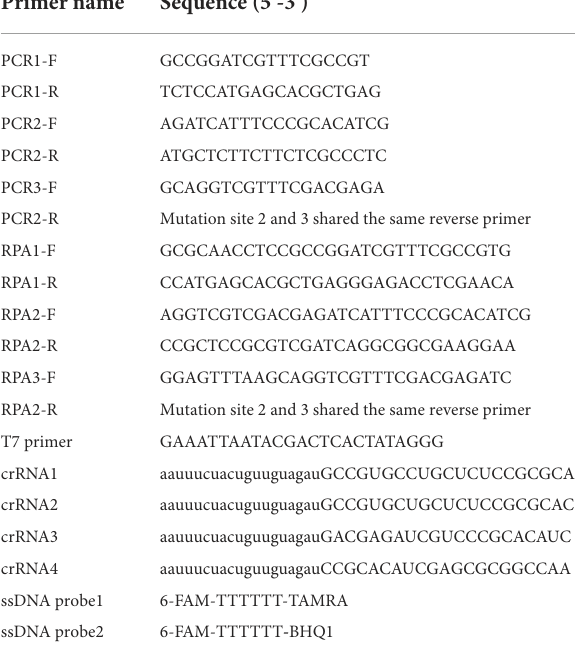
TABLE 1 Primer, crRNA, and ssDNA probe sequences used in the